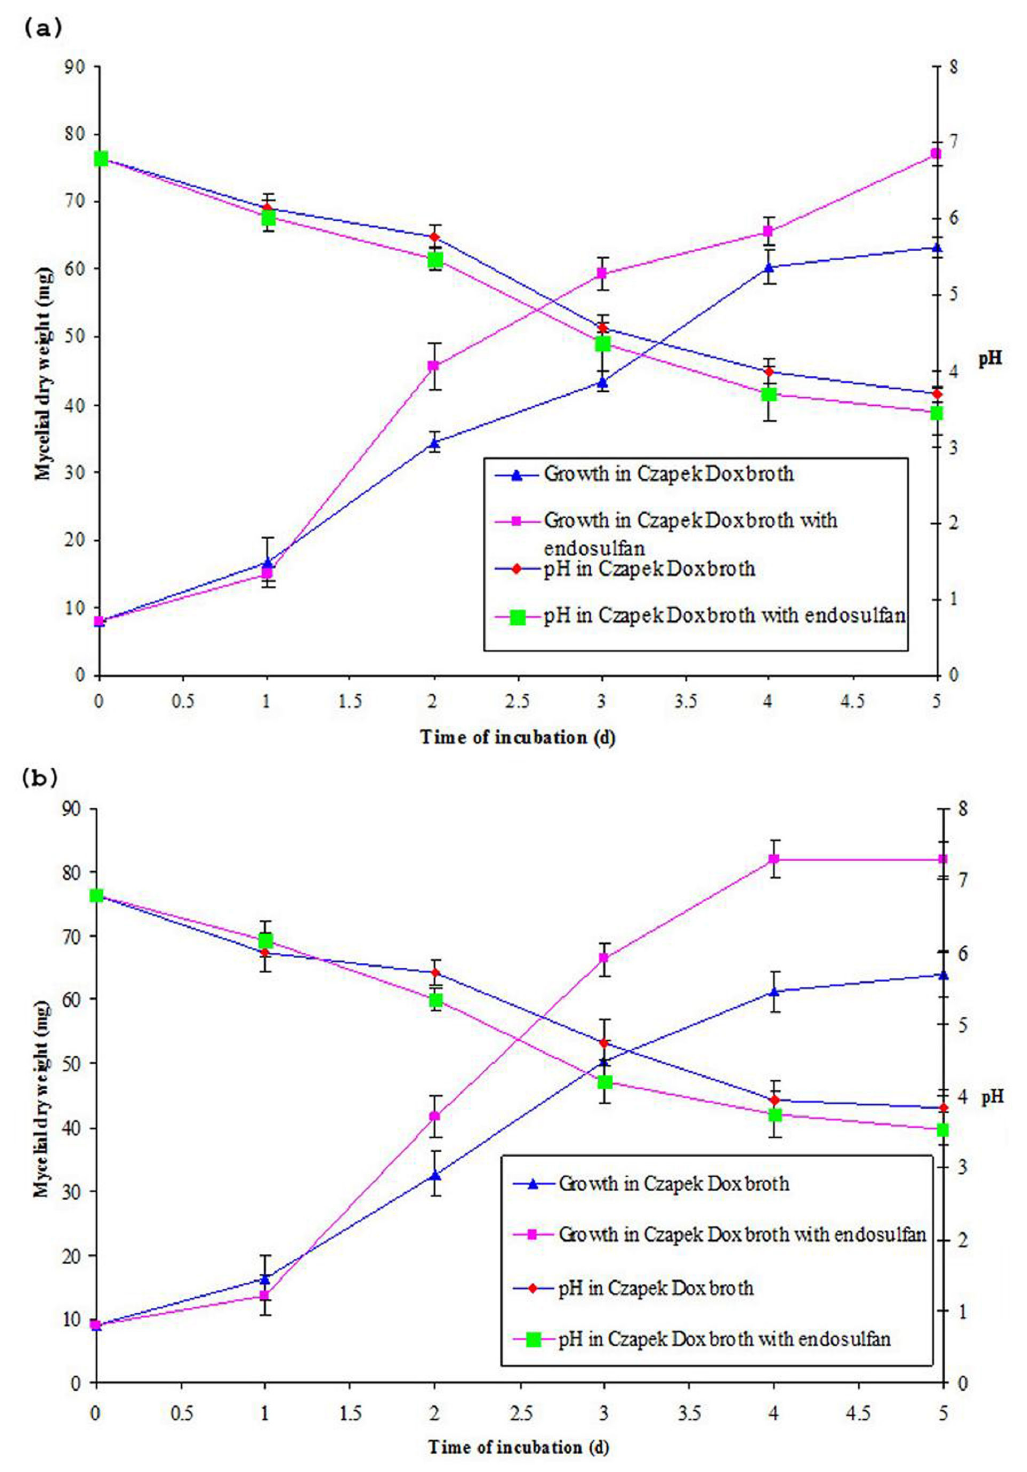
Figure 2. Fungal growth monitored in terms of biomass and culture pH in media. (a) Botryosphaeria laricina JAS6 gowth in presence and absence of endosulfan; (b) Aspergillus tamarii JAS9 growth in presence and absence of endosulfan. The interpolated curves are arbitrary and are there to guide the eye only. Each value is the mean of three replicates, with error bars representing the standard deviation of the mean. doi: 10.1371/journal.pone.0077170.g002 PLOS ONE |